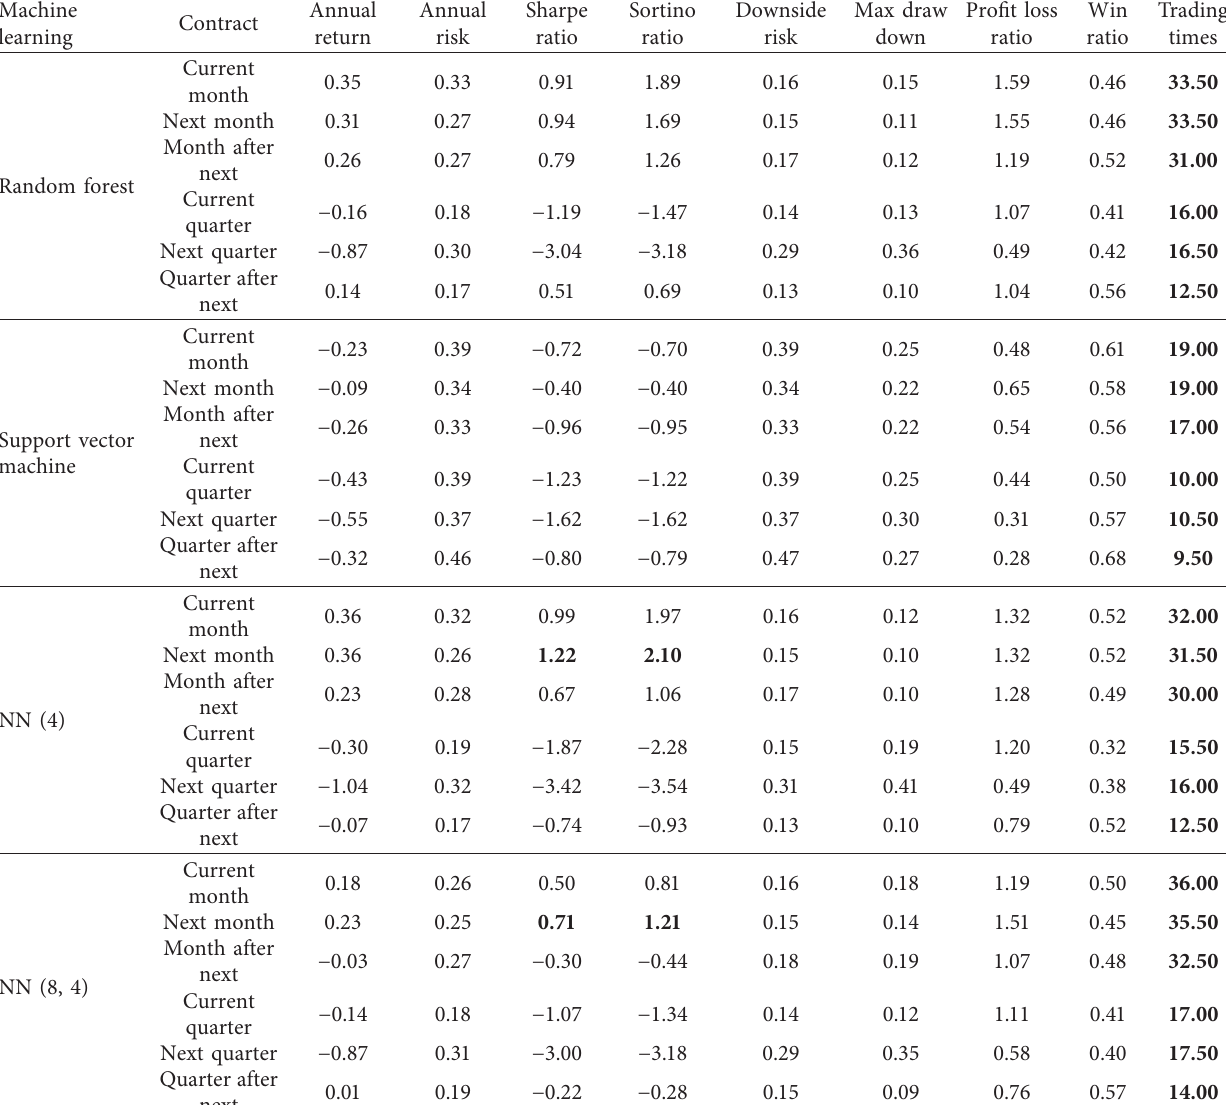
Table 10: Option strategy of predicting the rise and fall of volatility by threshold (use 30 features M4, threshold � 0.3). Machine